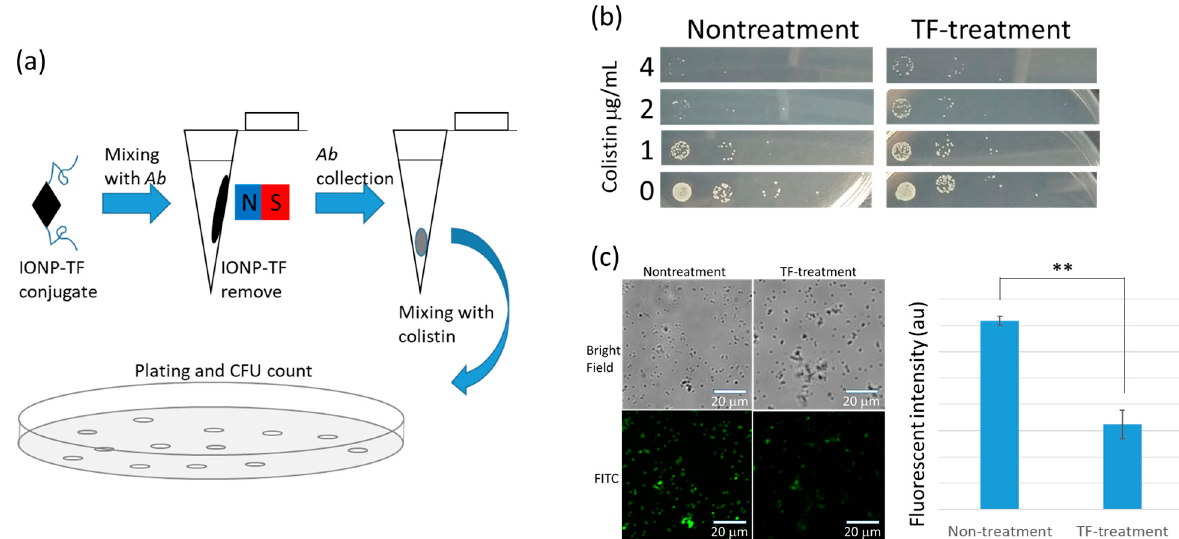
Figure 3. Mimicry of tail fiber (TF) protein effectiveness in phage initial infection and test of TF-induced colistin resistance. ( a ) TF conjugated iron oxide nanoparticles (IONP) were used to treat bacteria and magnetically removed before colistin challenge. ( b ) Determination of colistin resistance by counting the colony forming units. The resistance capability of the TF-treated bacteria is nearly an order of magnitude greater than control group. ( c ) Fluorescent images of colistin–fluorescein isothiocyanate (FITC) conjugate show that nontreatment bacteria exhibited higher colistin affinity than the TF-treated host, and the fluorescent intensity was significantly higher than the TF-treated group.